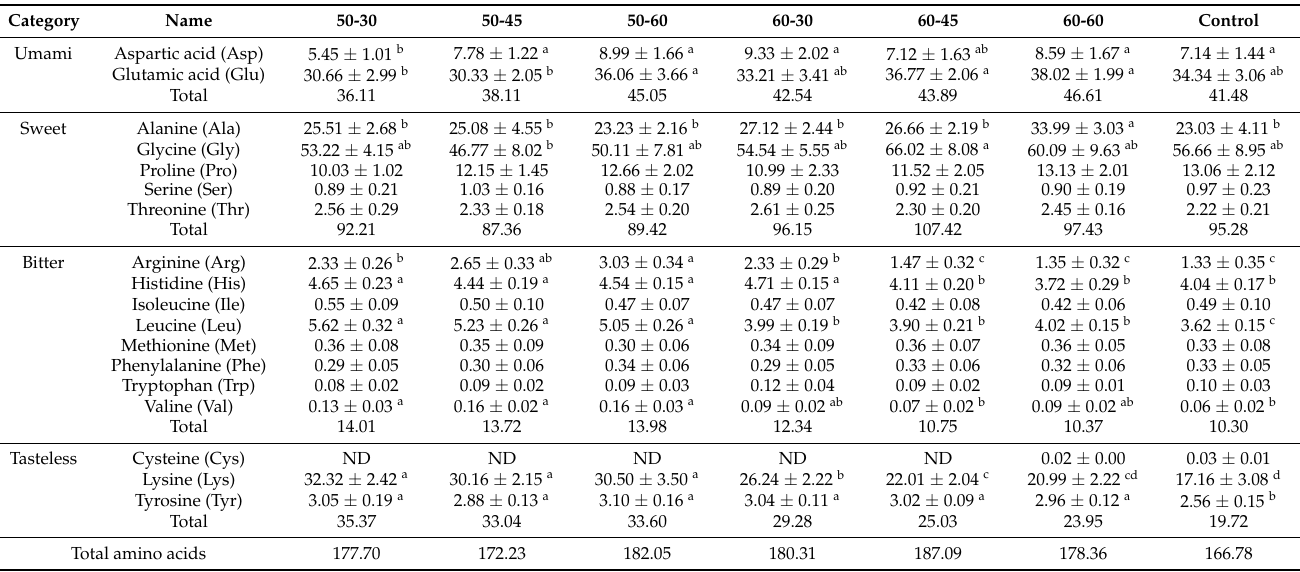
Table 1. Free amino acid composition of SV-cooked tilapia processed by various SV conditions (mg/100